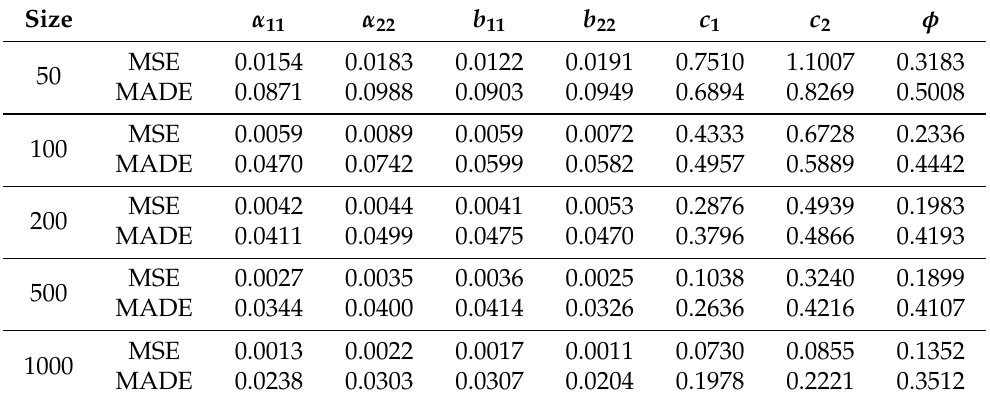
Table 3. Results for diagonal EBINAR(1) model with parameter